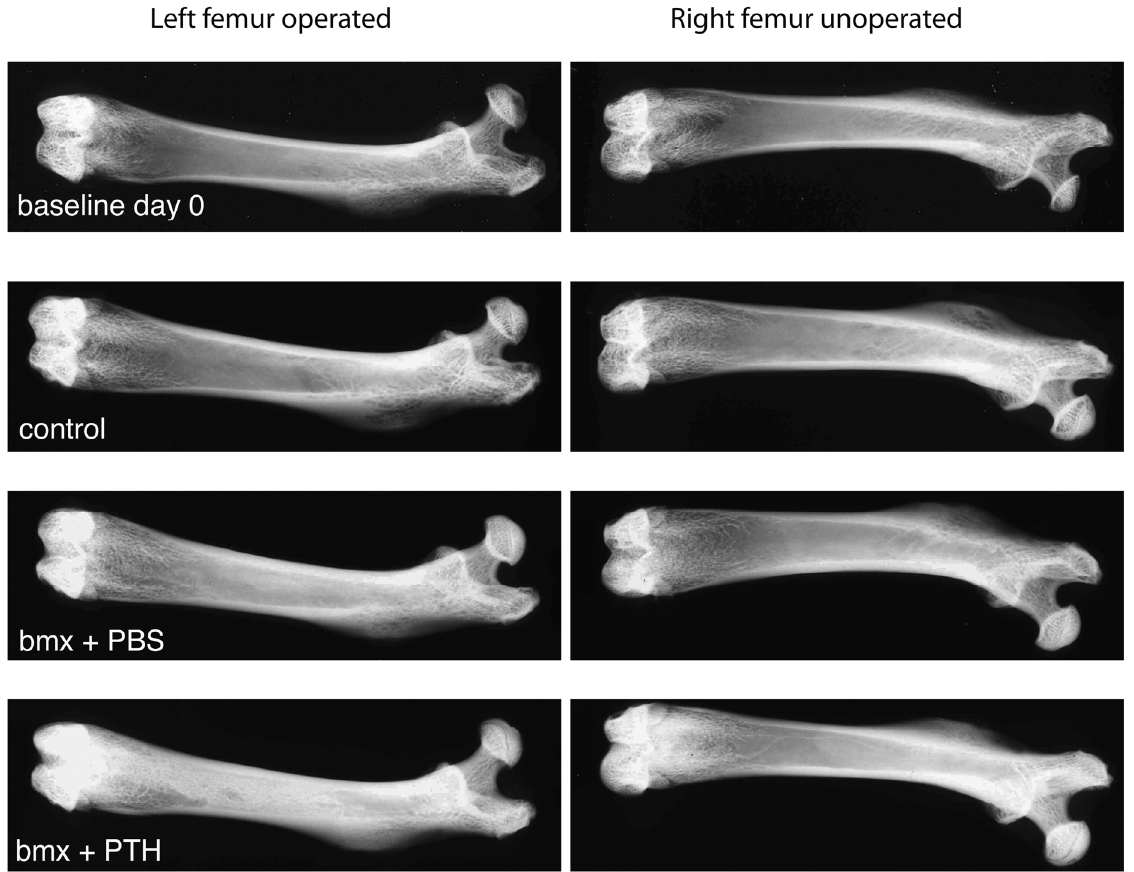
Figure 1. High-resolution radiographs of left operated and right unoperated femurs from baseline, control, and bone marrow-ablated (bmx) rats treated five days per week with phosphate buffered saline (PBS) or parathyroid hormone (PTH) for 28 days. X-ray images are representative of each group. Note the intense radio-opacity of the marrow ablated femur from rats treated with